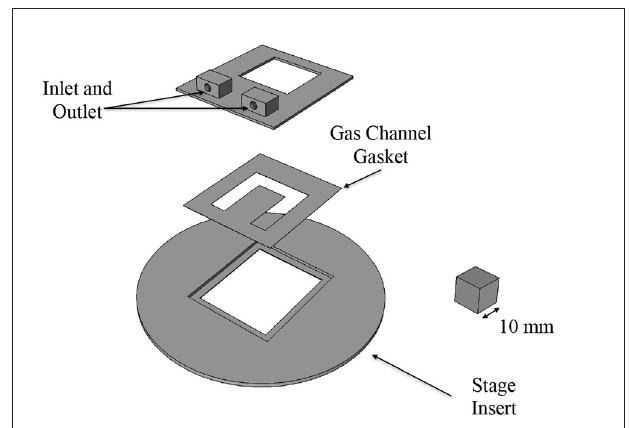
FIGURE 1 | Three dimensional CAD model of gas chamber components. Inlet/outlet mount and stage insert were 3D printed. The gas channel gasket was made out of polymethyl-methacrylate (PMMA). The gas channel is sealed on the bottom with a glass coverslip and on the top with a glass coverslip patterned with laser-cut exchange